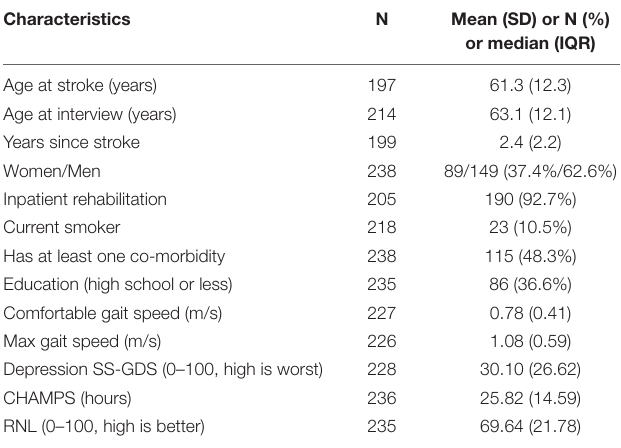
TABLE 1 | Demographic and clinical characteristics of the sample ( n = 238).